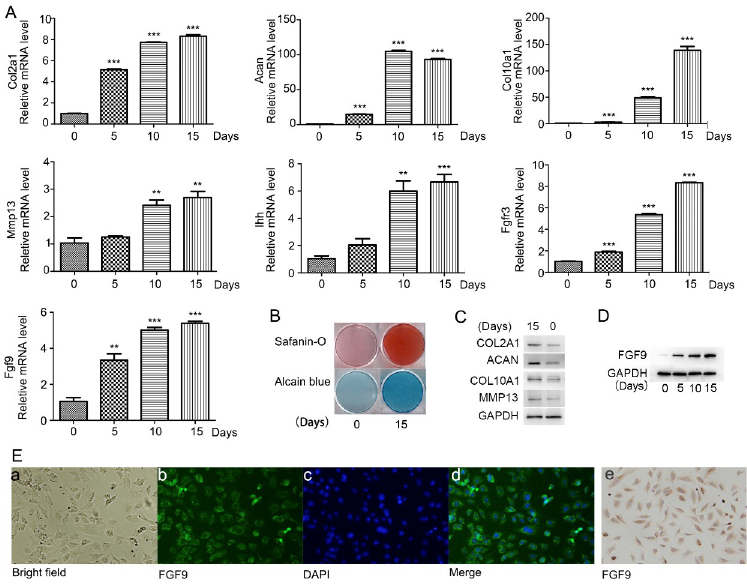
Fig 2. FGF9 expression increased during early differentiation of ATDC5 cells. ATDC5 cells effectively differentiated into chondrogenic cells and stayed at the early stage of chondrogenic differentiation by day 15 as detected by quantitative real-time PCR analysis of the chondrogenic genes Col2, Aggrecan, Col10, Ihh, Mmp13 and FGFR3 Safranin-O staining and Alcian blue staining were carried out on the 15th day and 0 th day of induction(B), as well as the protein levels of Col2a1, Acan, Col10a1, Mmp13 detected by Western blot (C). Quantitative real-time PCR (A) and Western blotting analysis (D) showed increased expression of FGF9 during 15 days of ATDC5 differentiation. Immunofluorescence staining (E/a-d) and immunohistochemical staining (E/e) were used to detect the expression and distribution of FGF9 in undifferentiated ATDC5 cells.